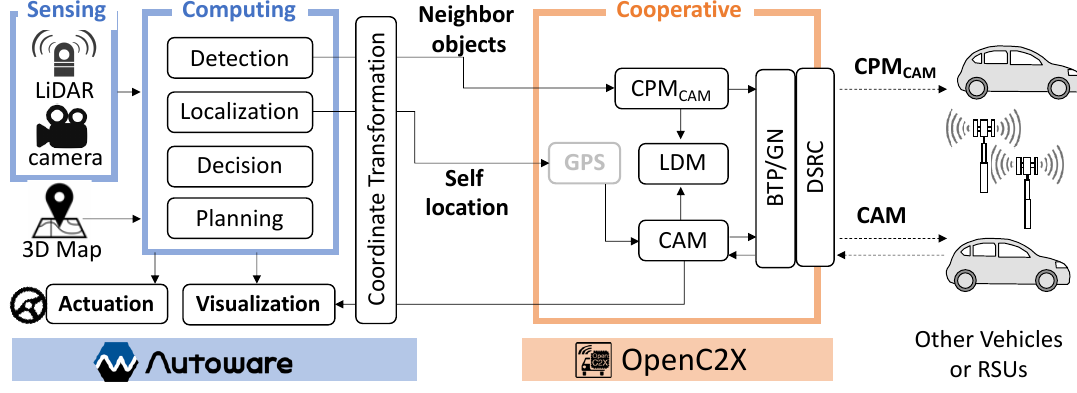
Figure 3. AutoC2X